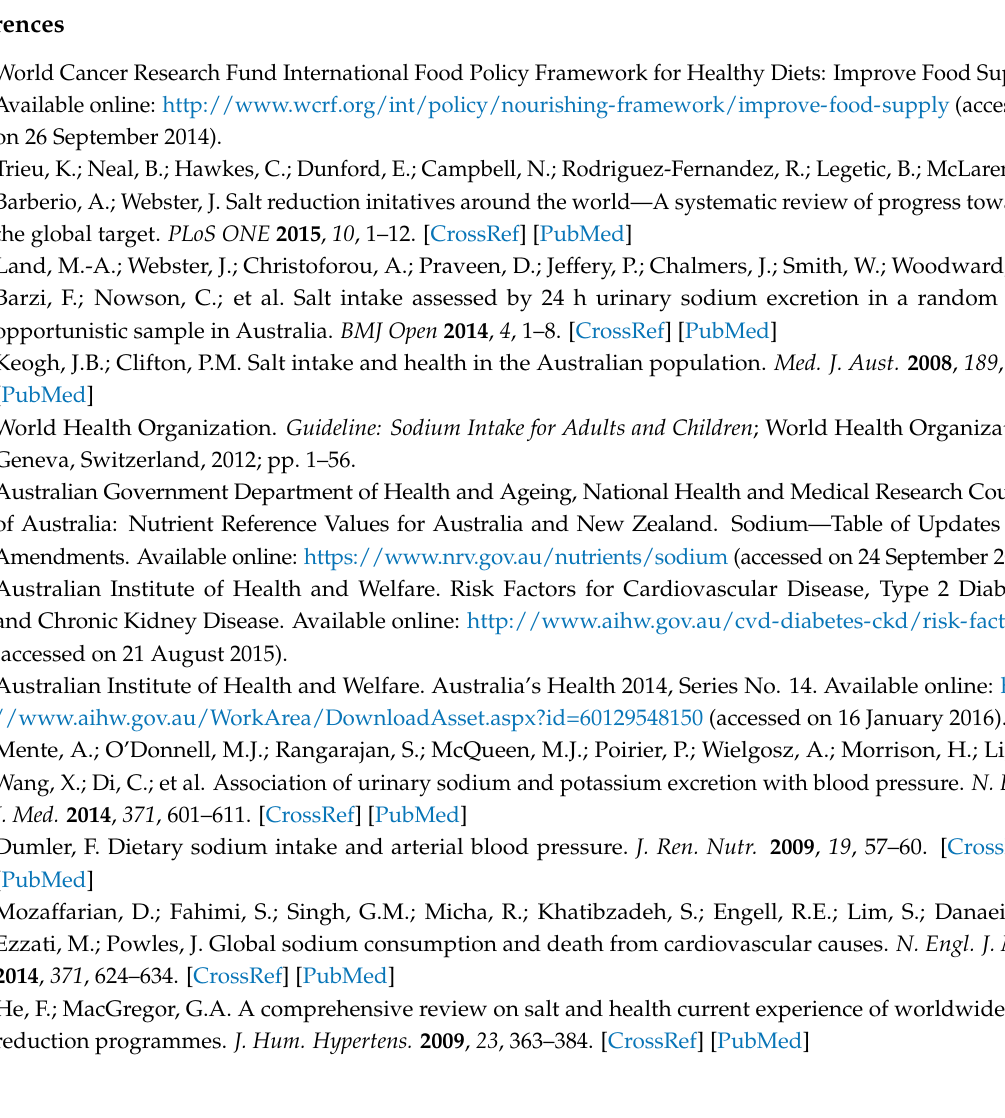
Figure S1: Advocacy intervention logic model, Figure S2: Change